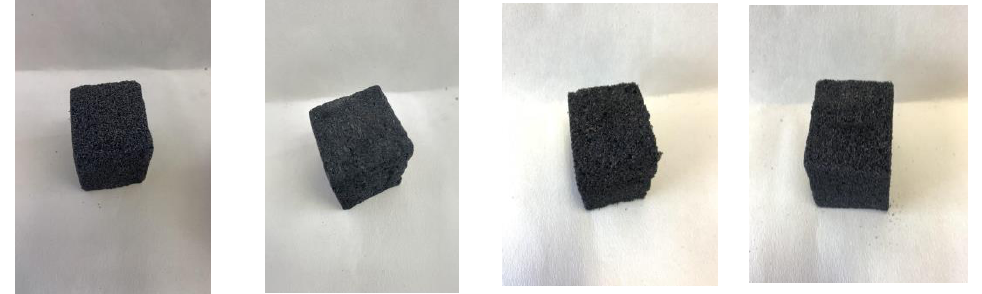
Figure 8. From left to right: examples of cubes of standard foam, Foam A, Foam B, Foam C, and Foam D. Foam